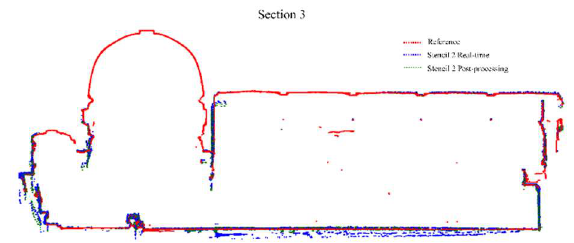
Figure 13. Comparison between the profiles of the reference point cloud, the Real-time Stencil 2 solution and the point cloud obtained after the data reprocessing, along the Section 3. Through the Agisoft Photoscan Professional software, 78 images were aligned (Figure 14) and then georeferenced using the same markers used for the registration of the clouds acquired with the Faro Focus Cam 3D system. Table 5 shows the characteristics of the resulting dense point cloud and estimated errors on the control points.